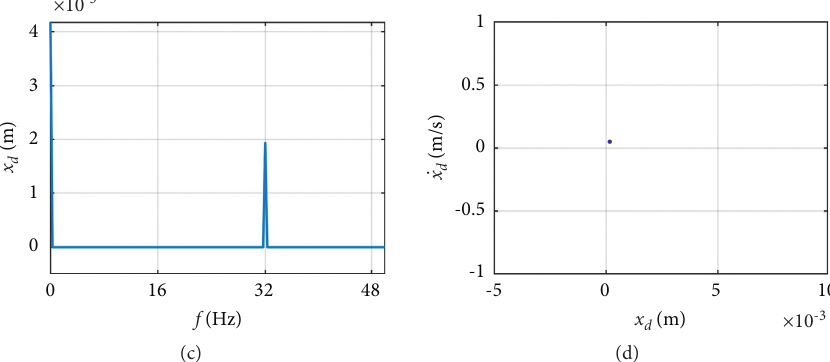
� 60 ) MN/m: (a) time history, (b) phase diagram, (c) frequency spectrum, and (d) s